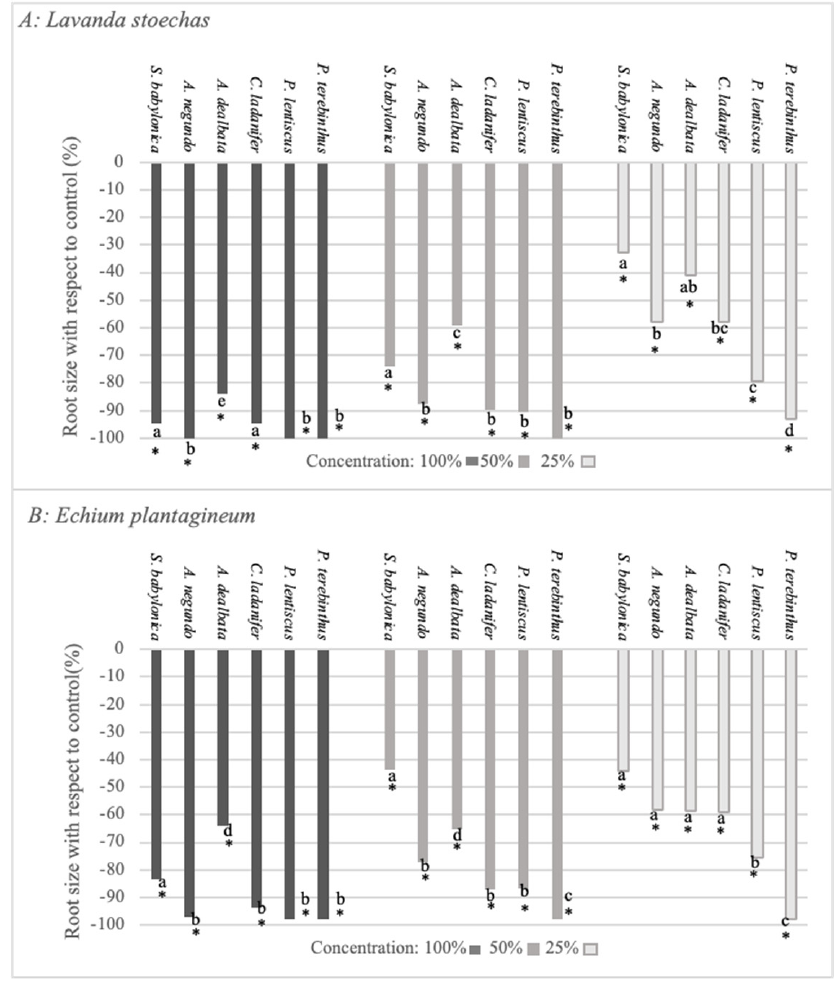
Figure 3. Effect of S. babylonica , A. negundo , A. dealbata , C. ladanifer , P. lentiscus , and P. terebinthus extract on root size of L. stoechas ( A ) and E. plantagineum ( B ) at 100%, 50%, and 25% concentrations; a, b, c, d, e: lowercase letters indicate significant differences between species on the same concentration (Mann-Whitney test, p < 0.05). *: Significant difference of control (Mann-Whitney test, p < 0.05). With respect to the effect caused by the extracts of these species on cotyledon emer- gence (Figure 4A,B), once again, L. stoechas was the most negatively affected, with C. ladanifer , P. lentiscus, and P. terebinthus maintaining a significant negative effect at the lowest concentration. On the other hand, A. negundo and P. terebinthus exerted the most negative effect on E. plantagineum at 100% and 50%. The lowest concentration (25%) of none of these species exerted significant inhibition on this parameter in E. plantagineum , and the extract of A. dealbata did not show significant effects at any of the analysed concentrations. Another morphological parameter quantified was cotyledon size (Figure 5A,B). As can be observed, these species exerted a negative effect on the growth of L. stoechas and E. plantagineum . In L. stoechas , the significant negative effect was maintained for A. negundo, C. ladanifer, P. lentiscus , and P. terebinthus at the lowest concentration, with the extracts of S. babylonica and A. dealbata showing no activity at this concentration. It is important to mention that P. terebinthus had the greatest negative effect, and S. babylonica and A. dealbata were the species with the lowest negative effect. The negative effect observed on cotyledon size in E. plantaginum , as well as for the rest of the parameters, was lower than that produced in L. stoechas . At the lowest extract concentration, only P. terebinthus maintained the negative effect. It is worth pointing out that A. dealbata did not have a negative effect at any of the analysed